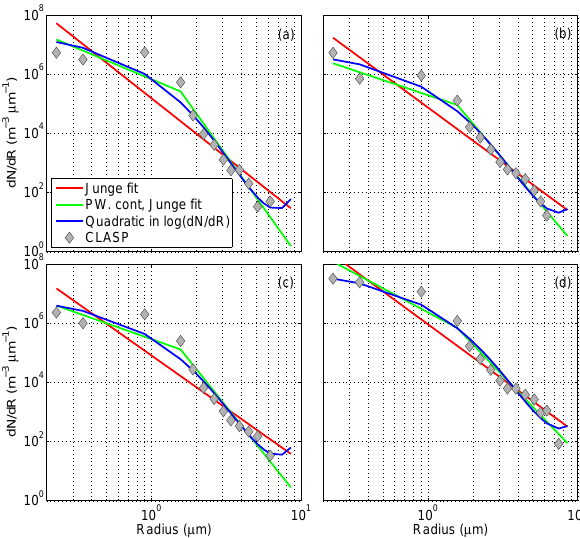
Fig. 3. Four different fits encompassing three different functional forms to aerosol spectra from four randomly chosen 20-min SEA- SAW runs. Table 1. Characteristics of β values of different Junge-type fits to the SEASAW data Mean Min